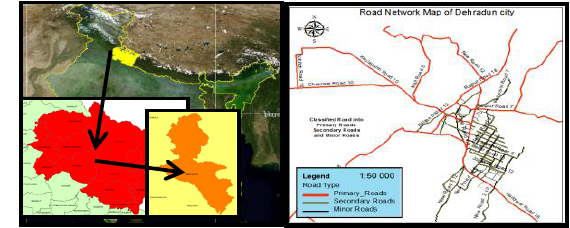
Figure 1: Index Map of the Study Area